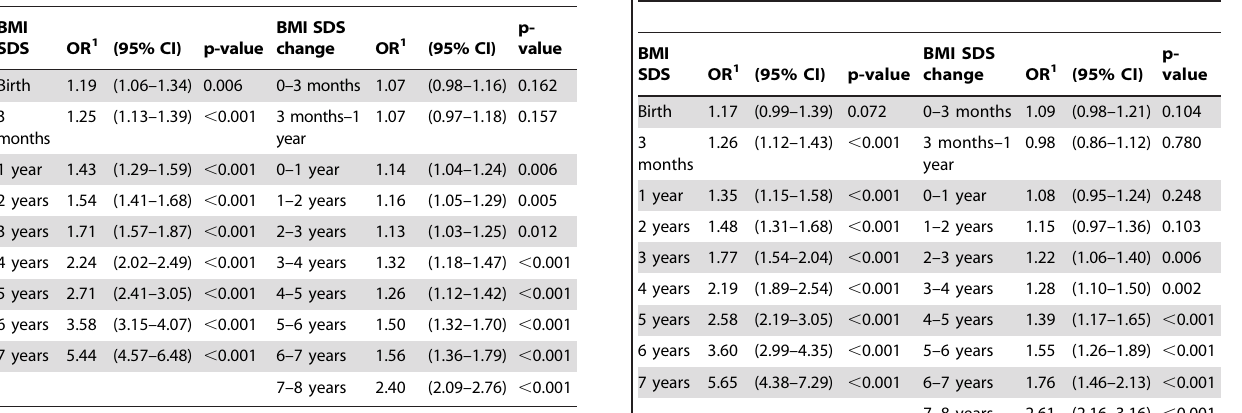
Table 5. Associations between BMI SDS and BMI SDS change from birth to 8 years of age and overweight at 8 years of age for boys (n=2055).